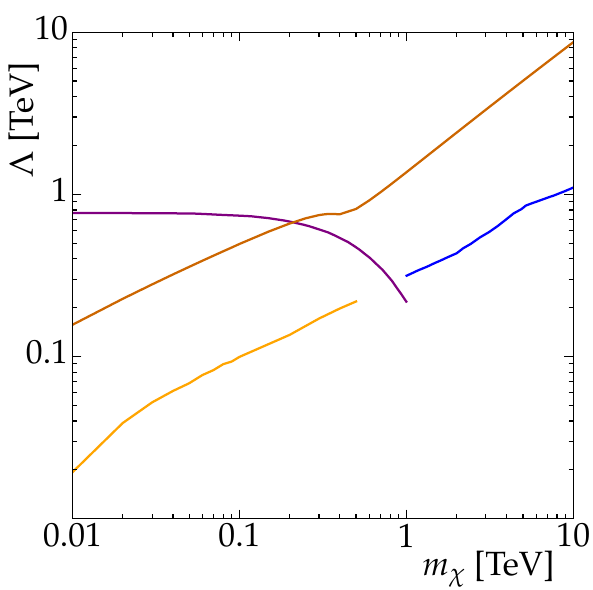
Figure 5 . Lower bound on the e(cid:11)ective operator scale (cid:3) as a function of the dark matter mass m (cid:31) from indirect detection experiments and collider experiments. The orange and blue lines denote the bound derived from (cid:13) -ray (cid:13)uxes from Fermi-LAT [14], and MAGIC [75] experiment. The dark matter relic density, as measured by the Planck collaboration [76], is satis(cid:12)ed when (cid:3) lies on the brown line. The purple line is the bound coming from mono- (cid:13) searches at the collider [44] for the operator L d =6 . If (cid:3) lies below the brown line then dark matter particles make up a fraction of the relic density using the 3-body annihilation channel. We set d 6 = d 8 =